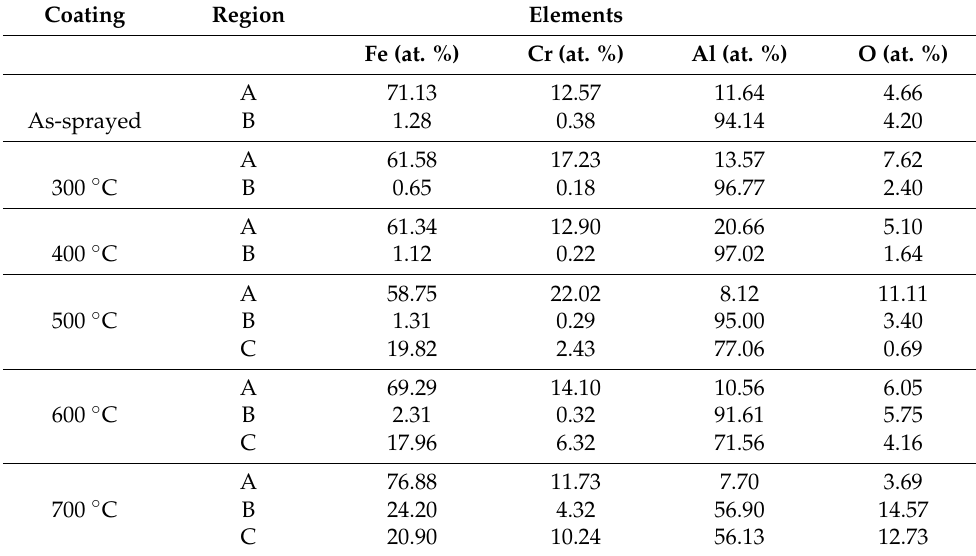
Table 1. EDS analysis of the different regions in the coatings. Coating Region Elements Fe (at. %) Cr (at. %) Al (at. %) O (at.